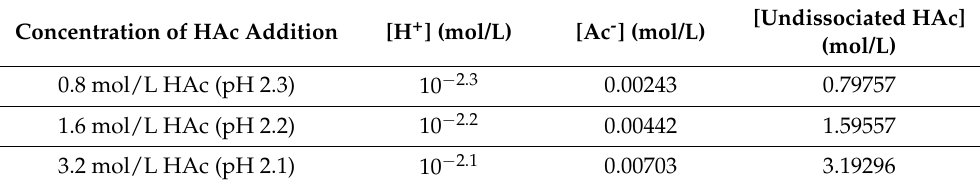
Table 3. Amounts of H + , Ac - and HAc in 0.6 mol/L NaCl solutions, with different concentrations of